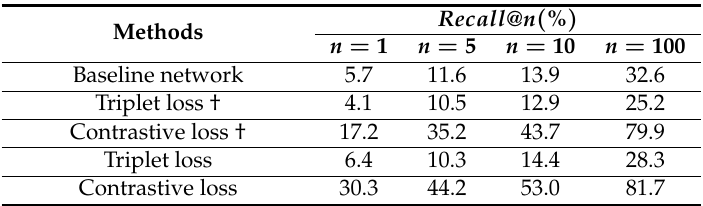
Table 2. Results of the conventional learning (without cross-channel pooling) method trained on the Google Earth South Korea dataset